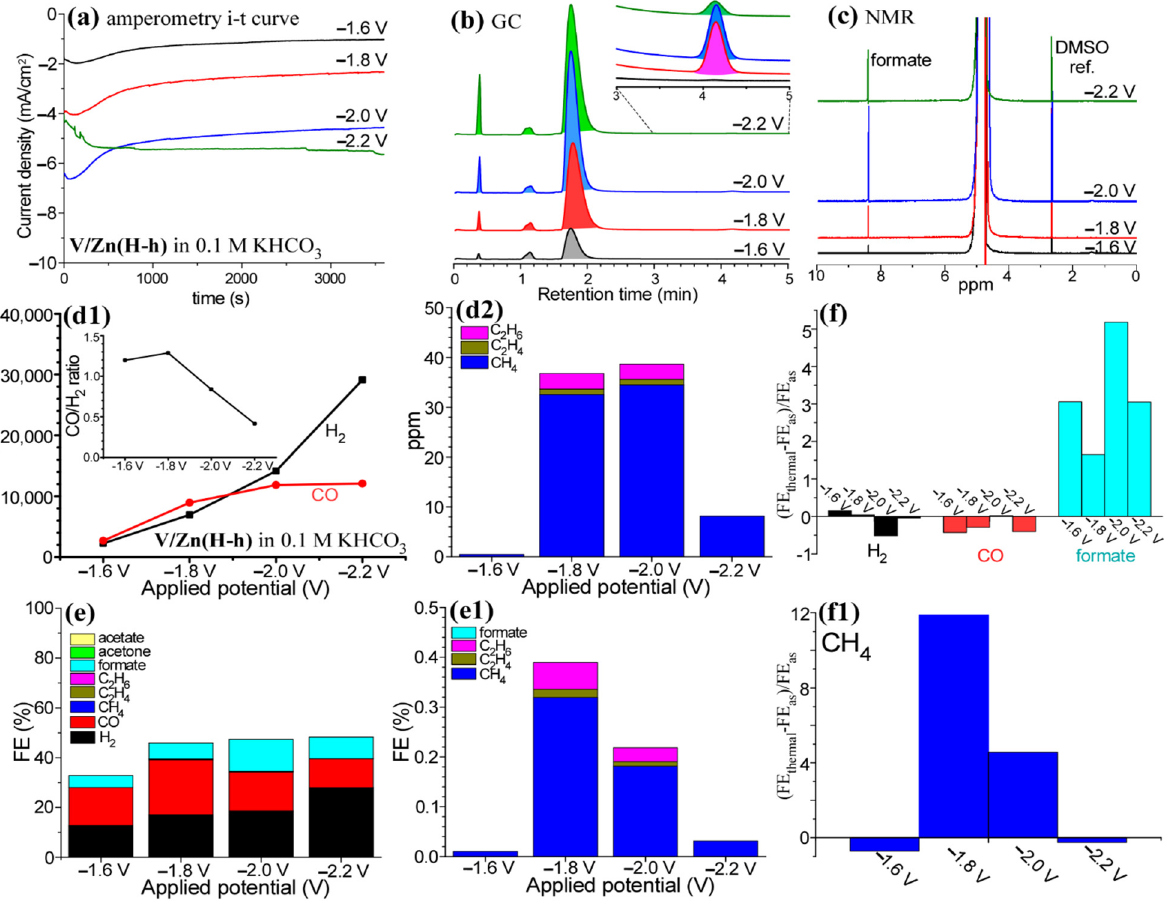
Figure 3. Amperometry i-t curves over V-Zn(H-h) electrode at various applied potentials of − 1.6 V, − 1.8 V, − 2.0 V, and − 2.2 V (vs. Ag/AgCl) in 0.1 M KHCO 3 electrolyte ( a ). Corresponding GC ( b ) and NMR ( c ) profiles for gas and liquid products, respectively. Measured H 2 and CO product amounts ( d1 ). CH 4 , C 2 H 4 , and C 2 H 6 amounts ( d2 ). Corresponding FEs of gas and liquid products ( e , e1 ). (FE V/Zn(H-h) − FE V/Zn(H) )/FE V/Zn(H) ratios for H 2 , CO, and formate productions ( f ). FE V/Zn(H-h) − FE V/Zn(H) )/FE V/Zn(H) ratios for CH 4 production ( f1 ).